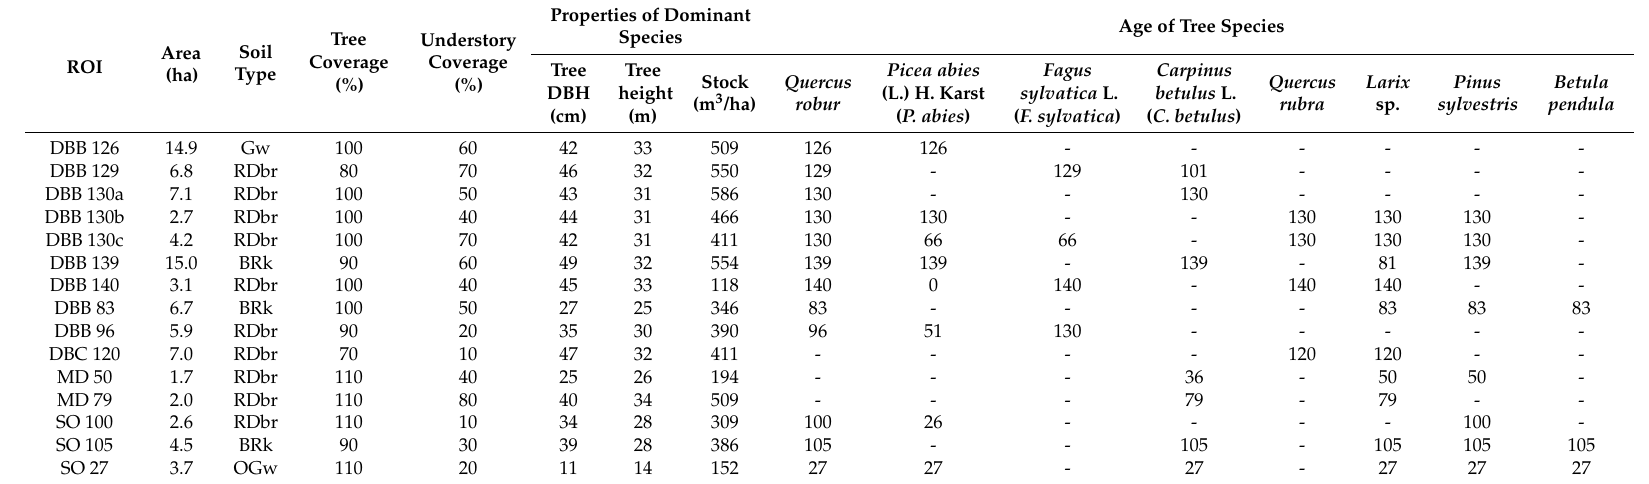
Table 1. Environmental tree parameters (Forest Data Bank). Dominant species name with its age: DBB for Q. robur , DBC for Q. rubra , MD for Larix sp., SO for P. sylvestris (the abbreviations come from polish names of dominant species and are used in polish Forest Data Bank). Soil type according to the Polish forestry nomenclature: OGw—rain-dependent gley soil; Gw—groundwater-dependent gley soil; Pw—lessive soil; BRk—acid brown soil; RDbr—rusty brown soil; due to its mineralogical composition, it is most permeable in our analysis. ROI—region of interest; DBH—diameter at breast